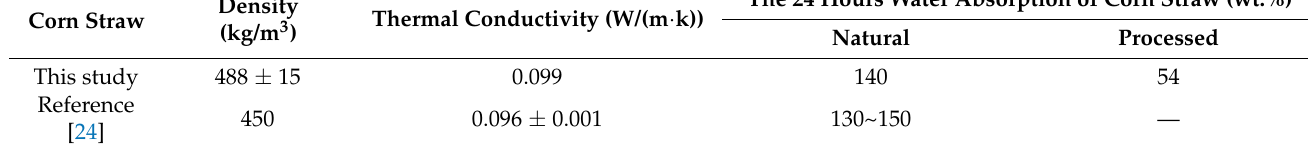
Table 5. Physical properties of corn straw.